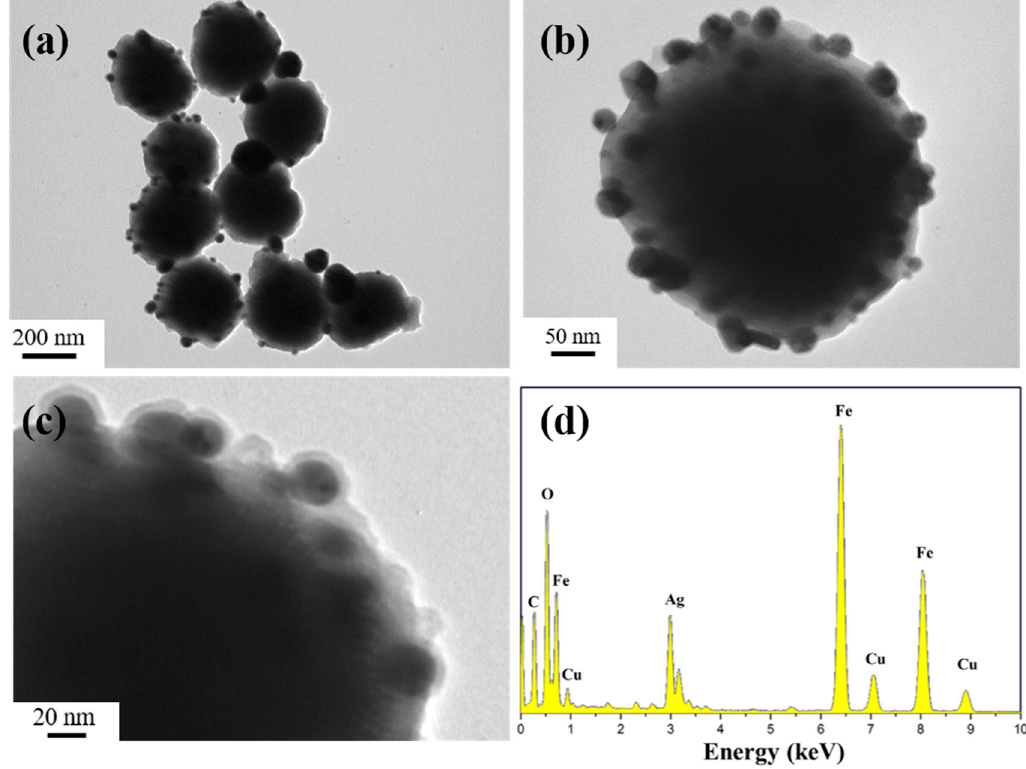
Figure 1. TEM images ( a – c ) and EDS spectra ( d ) of the Fe 3 O 4 @PDA/Ag/PDA nanospheres.